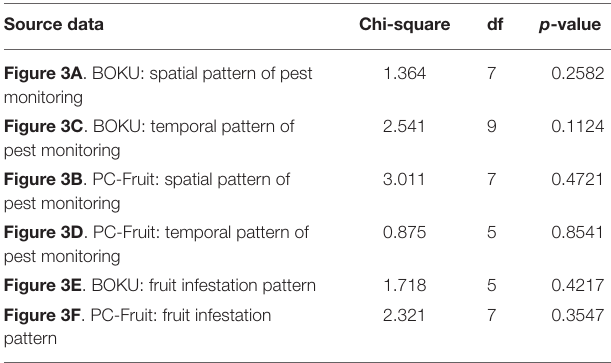
FIGURE 3 | On-farm IPM experiments: comparison between experimental vs. model-generated spatial and temporal pest monitoring and fruit infestation patterns.